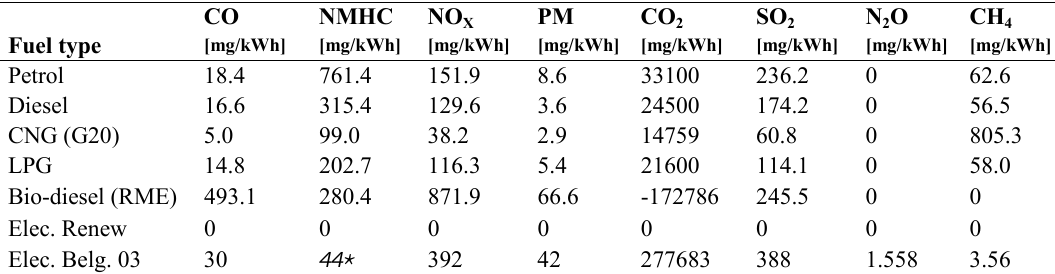
Table 2. Indirect emission